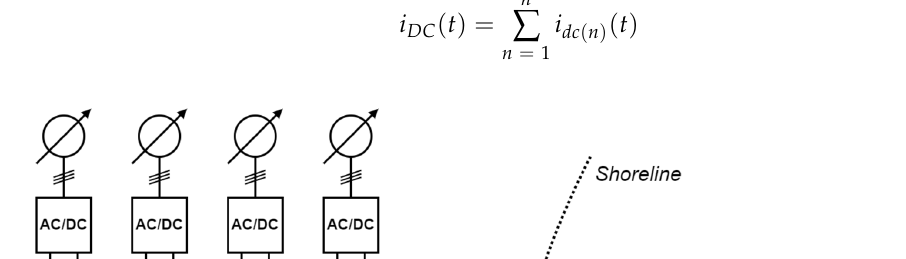
(3) Figure 9. Series DC collection grid. In [35], the efficiency of series-connected DC wind farms was evaluated. In compari- son with the AC collection and transmission at the Horns Rev offshore wind farm, it was shown that the series-connected DC wind farm could have a lower energy-production cost compared with traditional AC systems, especially for longer transmission lengths. The reason for this is that, since the transmission voltage is the aggregate of the voltage of all energy converters, HVDC transmission can be achieved without an HVDC offshore platform. As noted earlier, the offshore platform can be expected to be one of the single most expensive parts of an offshore wind farm. However, since the transmission voltage is maintained by the individual energy converters, the system needs to be able to handle large power fluctuations or the disconnection of energy converters. In [35], it was shown that the rated voltage of the energy converters needed to be 35% higher than the nominal voltage, where the latter is the transmission voltage level divided by the number of energy converters in one string. Further, the series-connected DC topology will put high stress on insulation. If, for example, the last energy converter in a string (as seen from the